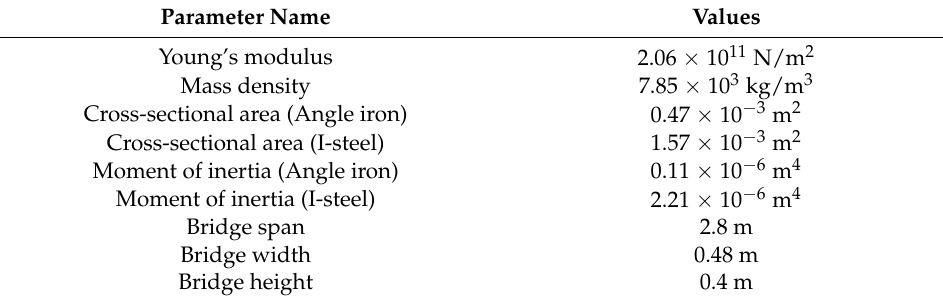
Figure 2. Configuration of ten measurement points on the bridge deck.